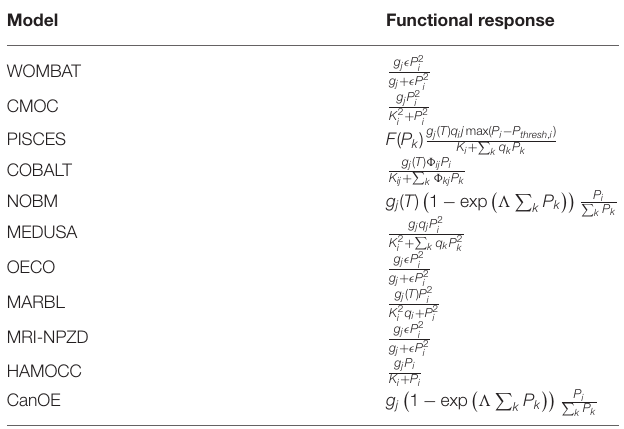
Afactorof1.0indicatesthattheprocessisunaffectedbytemperature,whileablankvalue indicates that the process is not explicitly resolved in a model. *Particulate production in BLING is temperature dependent but implicit and, therefore, difficult to quantify via a Q10 factor. **COBALT includes temperature dependence for viral loss and basal respiration but not foraggregation. Note:for models using theArhennius equation, whereQ10 varies slightly with temperature, we have indicated the mean Q10 over 10–20 ◦ C.